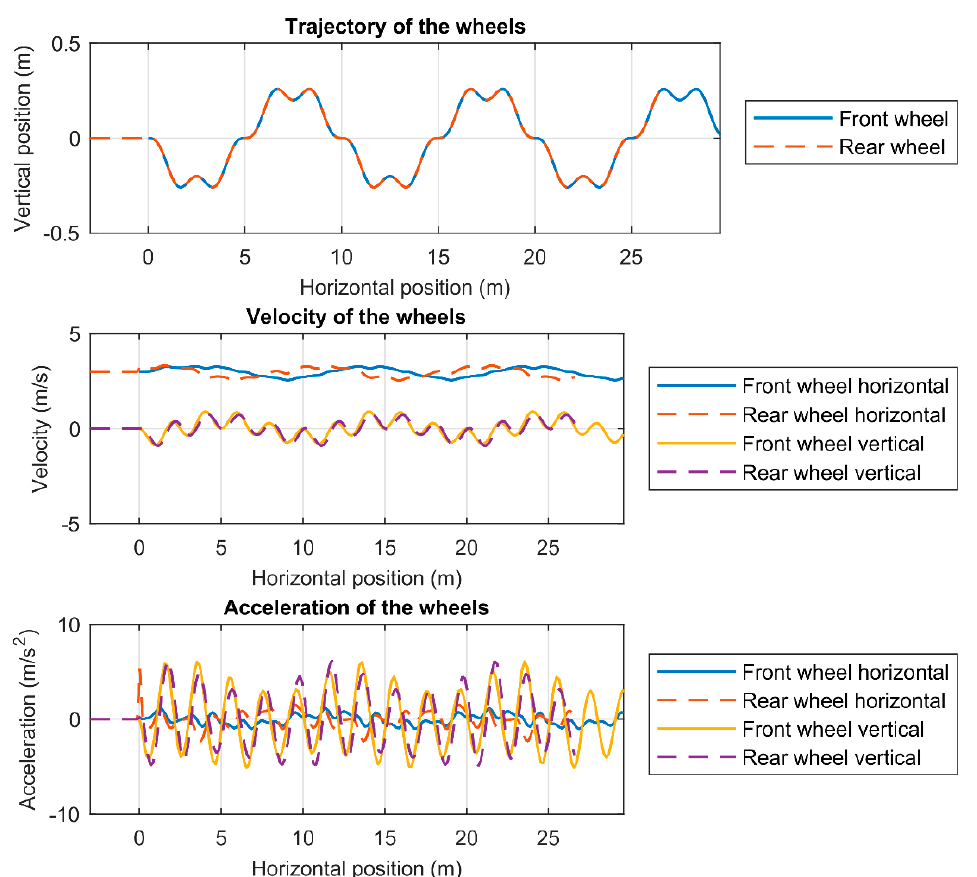
Figure 13. Kinematics of the vehicle when traveling through the second ground profile.